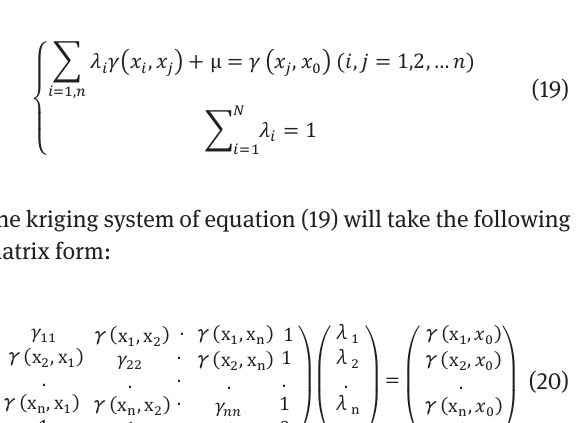
Figure 3: Spatial distribution and histogram of liquefaction potential